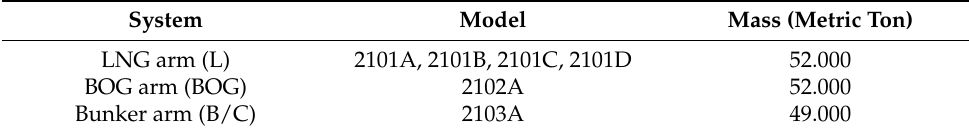
Table 2. Six models of the ULA system.